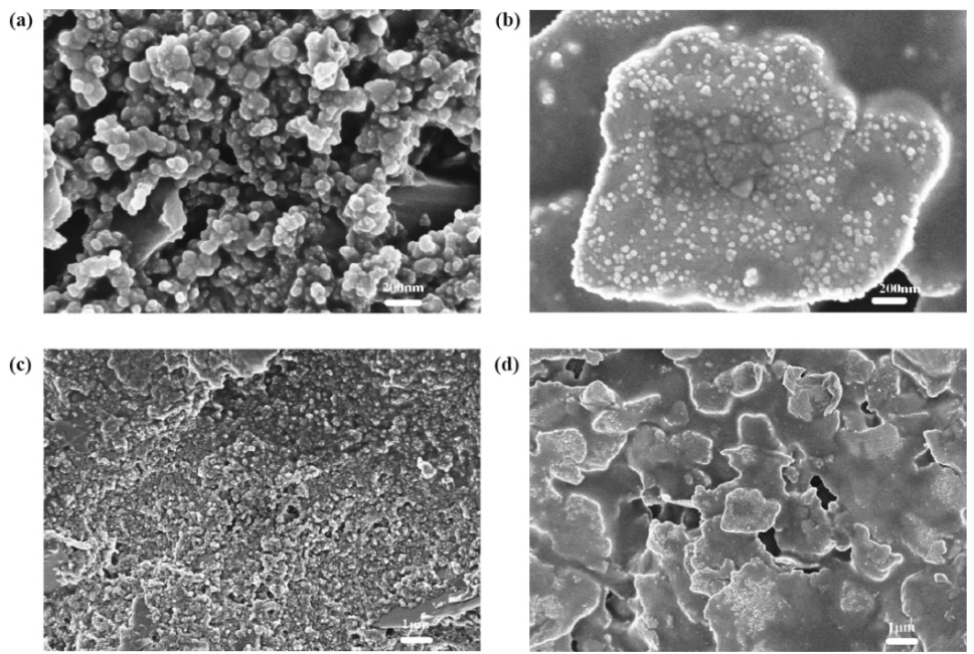
Figure 8. SEM images of carbon black layer and the silver layer: ( a ) and ( c ) are the surface of carbon black layer with a magnification of 50,000 times and 8000 times, respectively; ( b ) and ( d ) are the surface of silver layer with a magnification of 50,000 times and 8000 times, respectively.